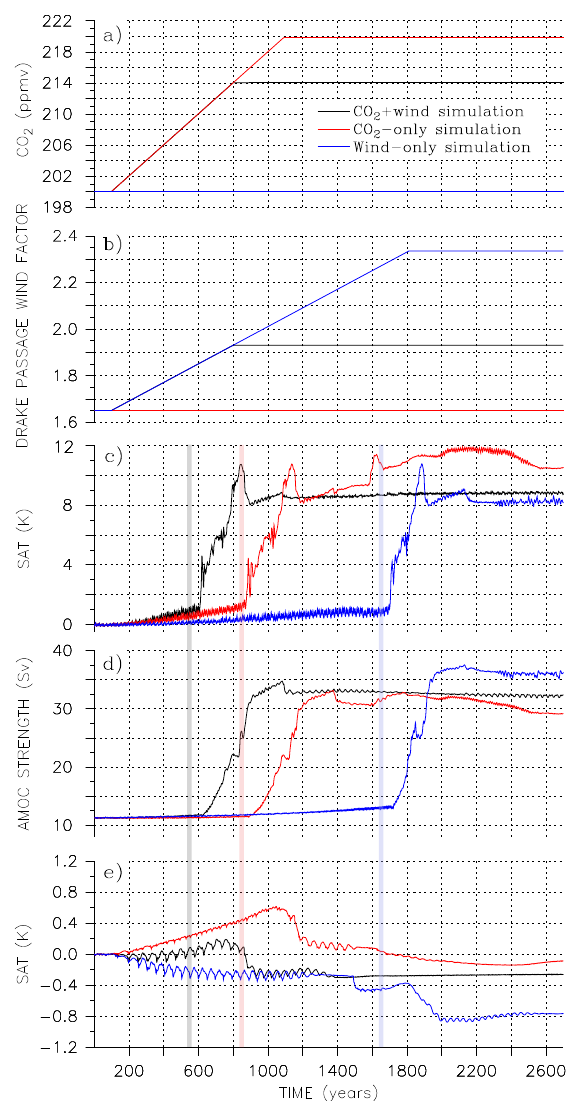
Fig. 2. Climatic patterns describing the interstadial state: (a) AMOC stream-function in Sv; (b) SAT anomalies with respect to the stadial state in K; (c) interstadial minus stadial maximum convective depth differences in m. Black and red lines show the locations of the 90% northern summer (June–August) average sea ice concentration for the stadial and the interstadial regime,